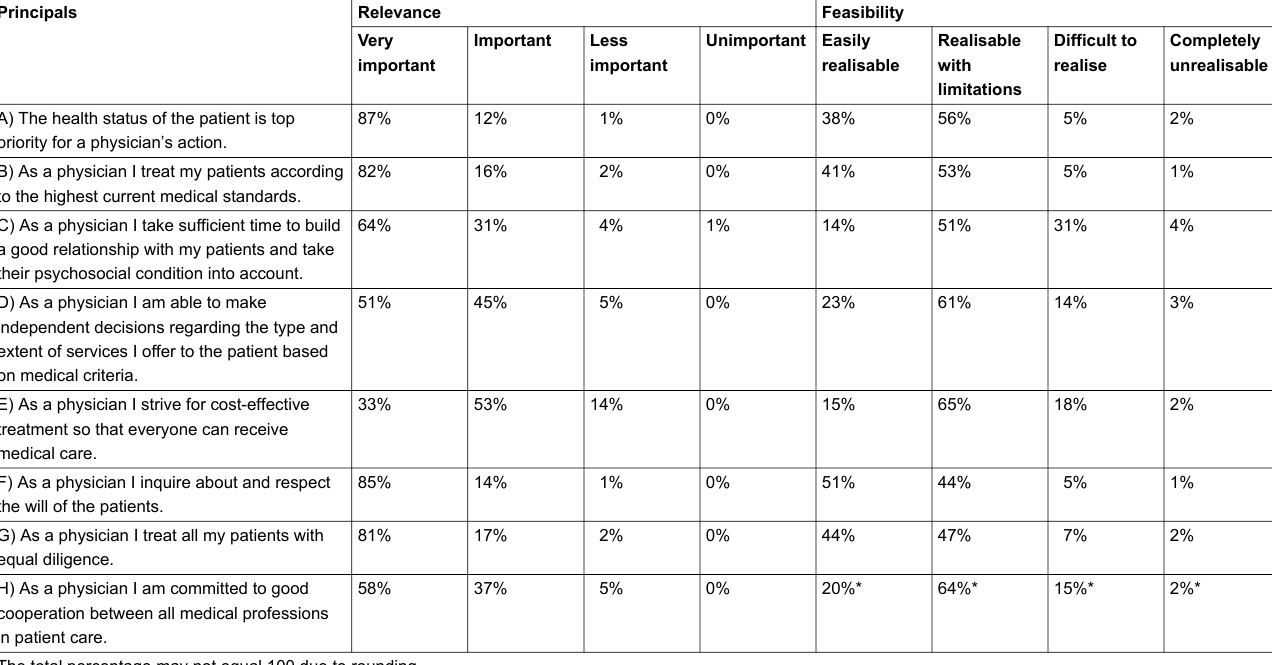
Table 5: Moral principles for physicians – relevance and realisability [percentages], n =